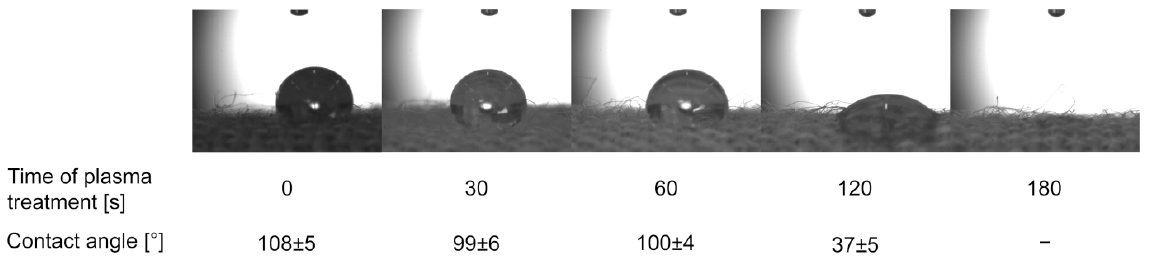
Figure 1 : Wettability of raw and plasma-treated linen fabrics as a function of time of plasma treatment.